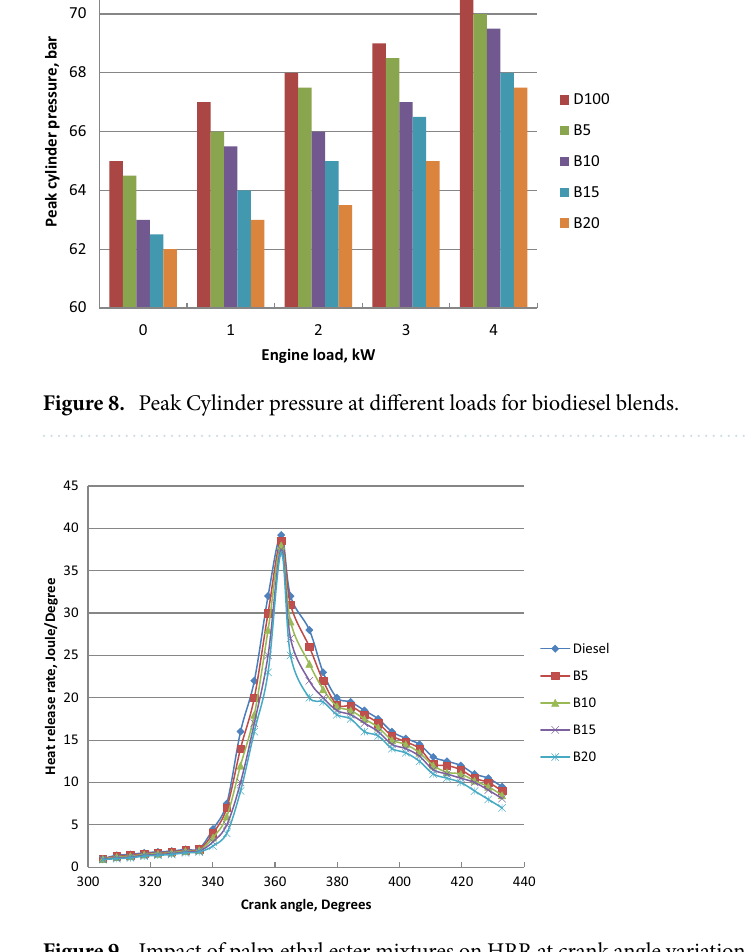
Figure 9. Impact of palm ethyl ester mixtures on HRR at crank angle variation and full